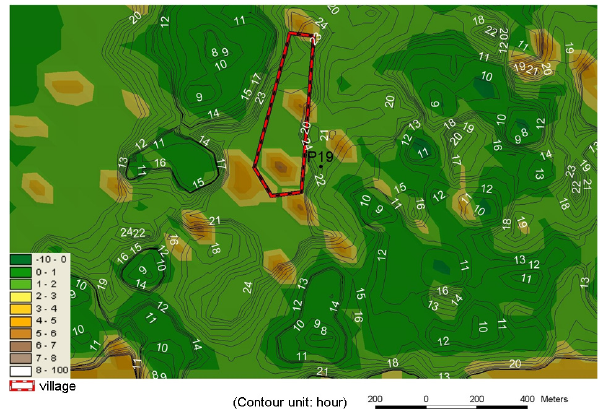
Fig. 14. Topography around P19 with the inundation contours of 20-cm depth advancing with elapsed time (by hour) in Typhoon